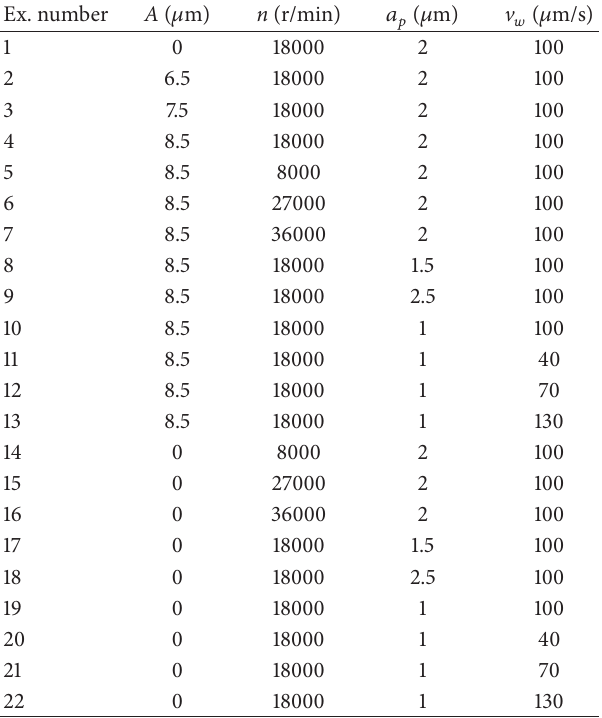
Table 3: Parameters of microgrinding experiment. Ex. number